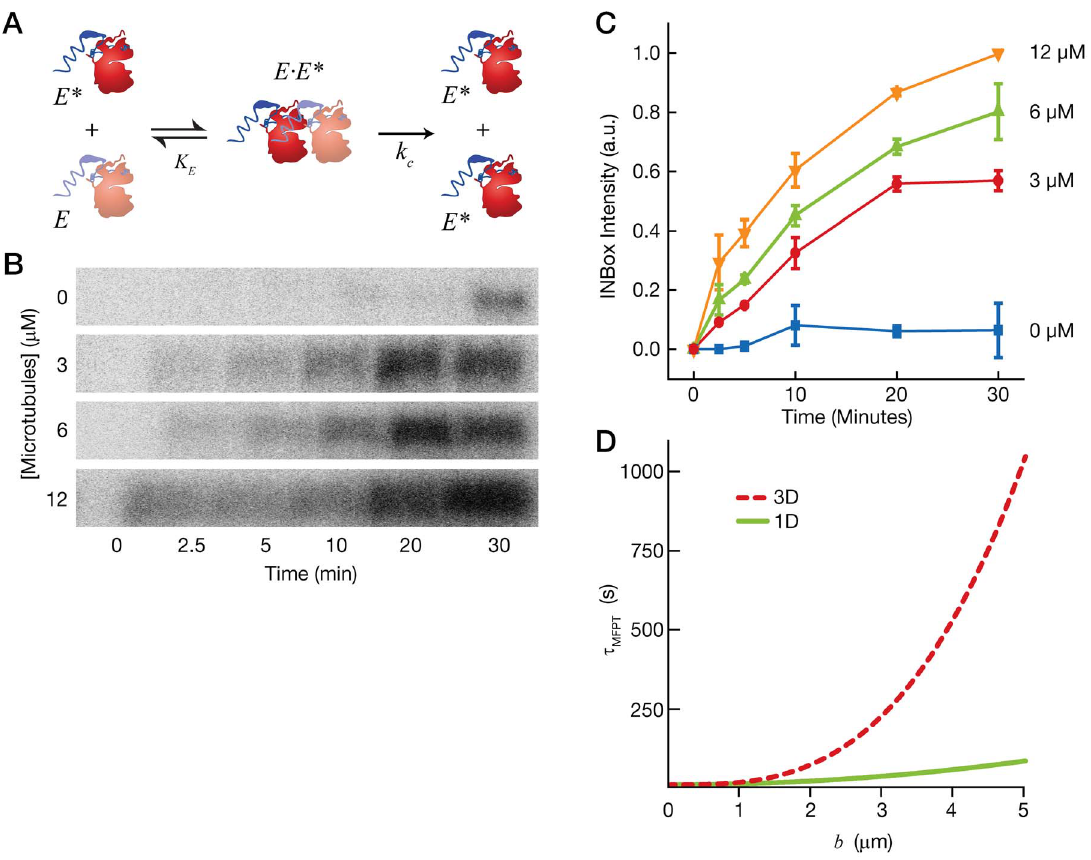
Figure 3. Microtubules accelerate Aurora-B activation by a reduction in dimensionality. ( A ) Schematic of a model for Aurora-B auto- activation. An active kinase ( E (cid:2) , bright red) binds to an inactive kinase ( E , dim red) with an equilibrium constant, K E , to form a complex, E : E (cid:2) . The kinase reaction occurs with a catalytic constant, k c , producing two active kinases ( right ). ( B ) Images of c 32 P radiograms showing radioactive bands corresponding to phosphorylated INBox motif. The images correspond to 4 microtubule concentrations (labeled at left ). The lanes in the radiogram correspond to different time points (labeled at bottom ). At higher microtubule concentrations, the radioactive bands become more intense at earlier time points. ( C ) Plot of the INBox motif band intensity against time for 4 microtubule concentrations. ( D ) Plot of the mean first passage time, t MFPT , against the size of the confining space in which the molecules diffuse, b . The plot shows both 3D diffusion (red hashed line) and 1D diffusion (green solid line) using the diffusion coefficients for Aurora-B (3D case, estimated; 1D case, measured). 1D diffusion is significantly faster when the molecules diffuse within spaces w 2 m m in radius.